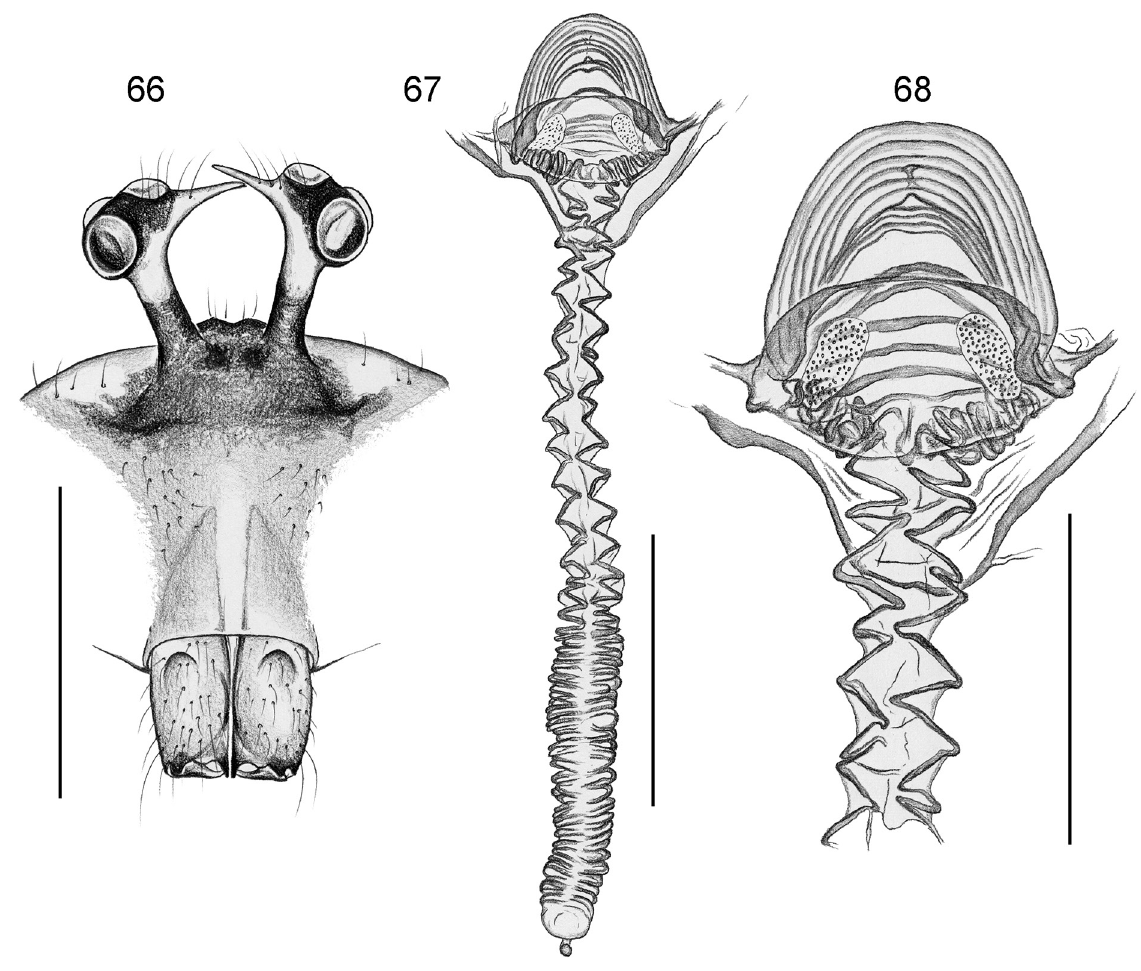
Figs 66–68. Panjange hamiguitan Huber sp. nov. (ZFMK, Ar 13009, 13012). 66 . Male prosoma and chelicerae, frontal view. 67 . Cleared female genitalia, dorsal view (proximal part of scape partly extended). 68 . Detail of Fig. 67. Scale bars: 66–67 = 0.5 mm; 68 = 0.3